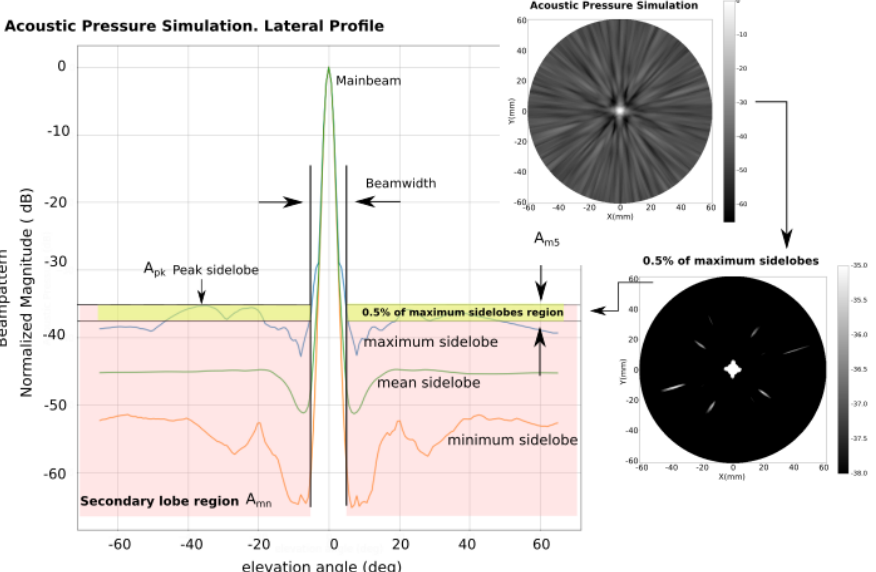
Figure 4. Elements used to evaluate the beampattern simulation. The beampattern is simulated in a semi-sphere ( θ ∈ [ − 90 ◦ : ∆ α : + 90 ◦ ] , φ ∈ [ 0 ◦ : ∆ α : 180 ◦ ] , ∆ α = 1 are composed of the semi-sphere by obtaining, at each elevation angle, the maximum, the mean and the minimum. The peak sidelobe ( A pk ) and the mainlobe width ∆ θ A value of the sidelobes is A mn . Furthermore, finally, the 0.5% percentile of the maximum sidelobes is identified and evaluated by its mean value ( A m 5